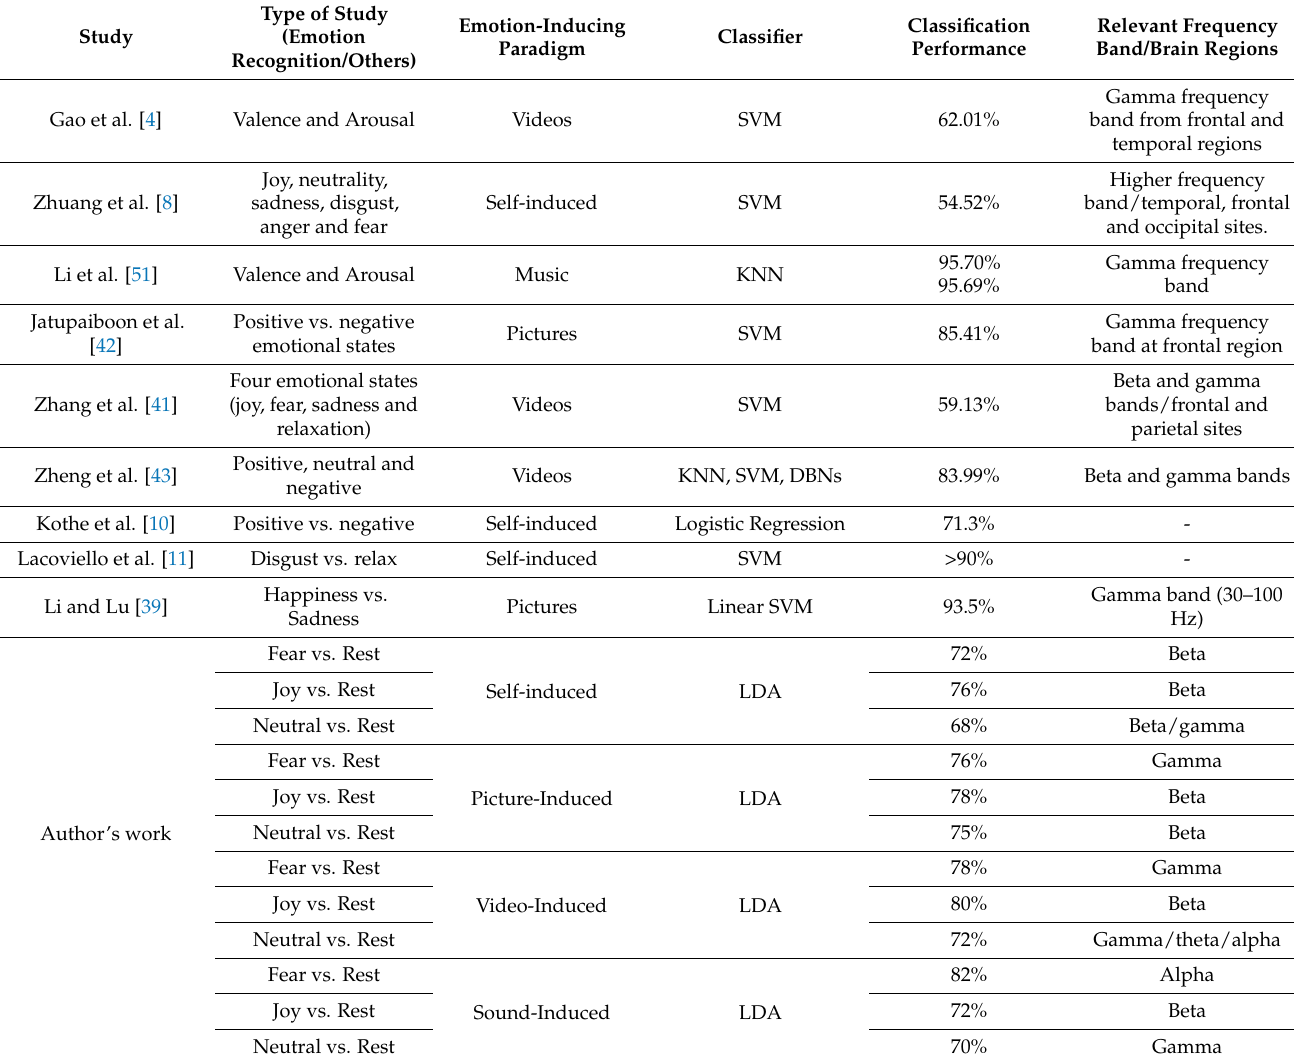
Table 4. List of studies using EEG signals to perform emotion